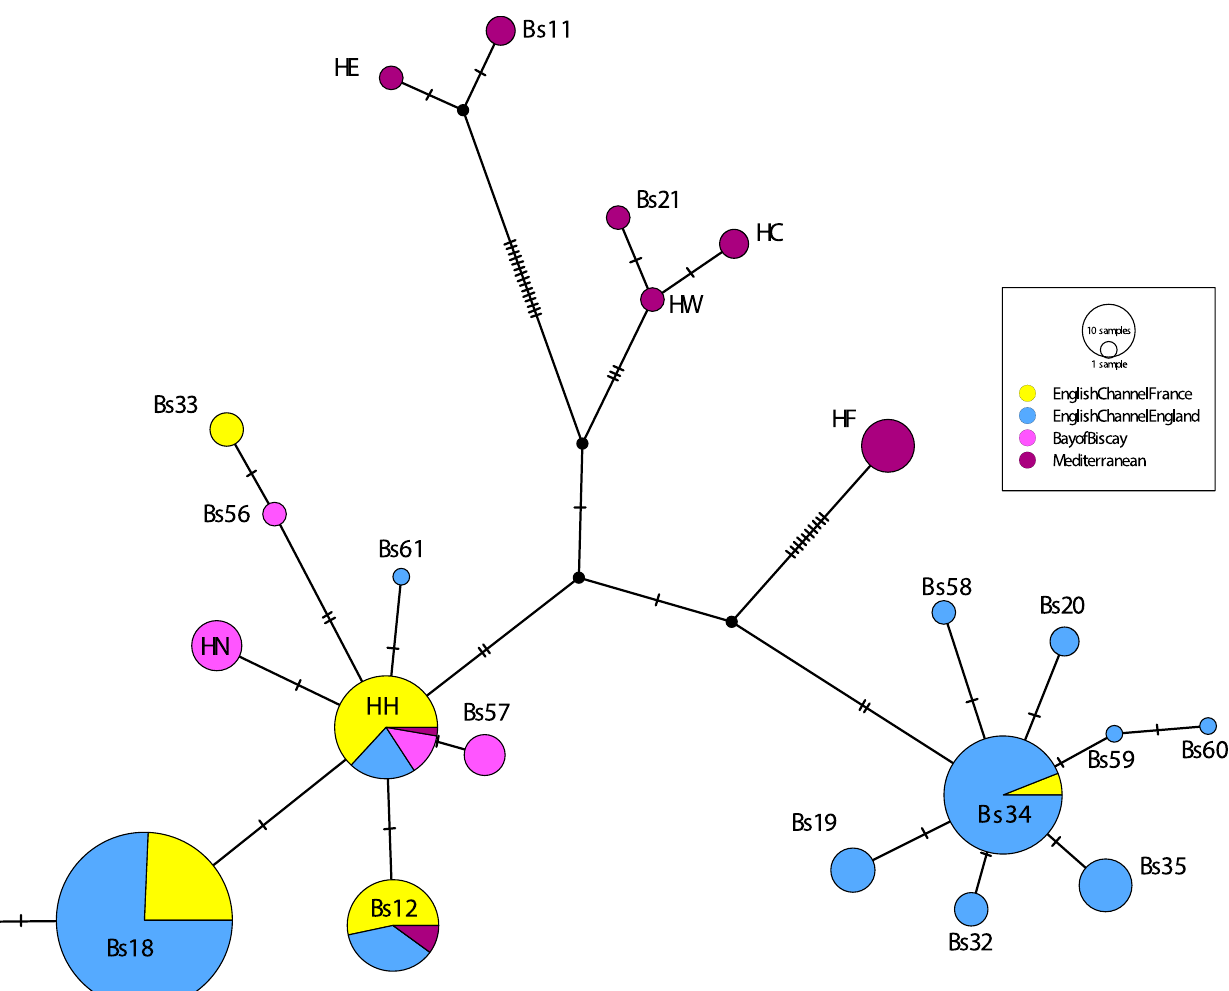
Fig 5. Median joining haplotype network of all Clade E populations. Populationsare groupedinto four geographic regions: EnglishChannelFrance, EnglishChannelEngland, Bay of Biscay, and